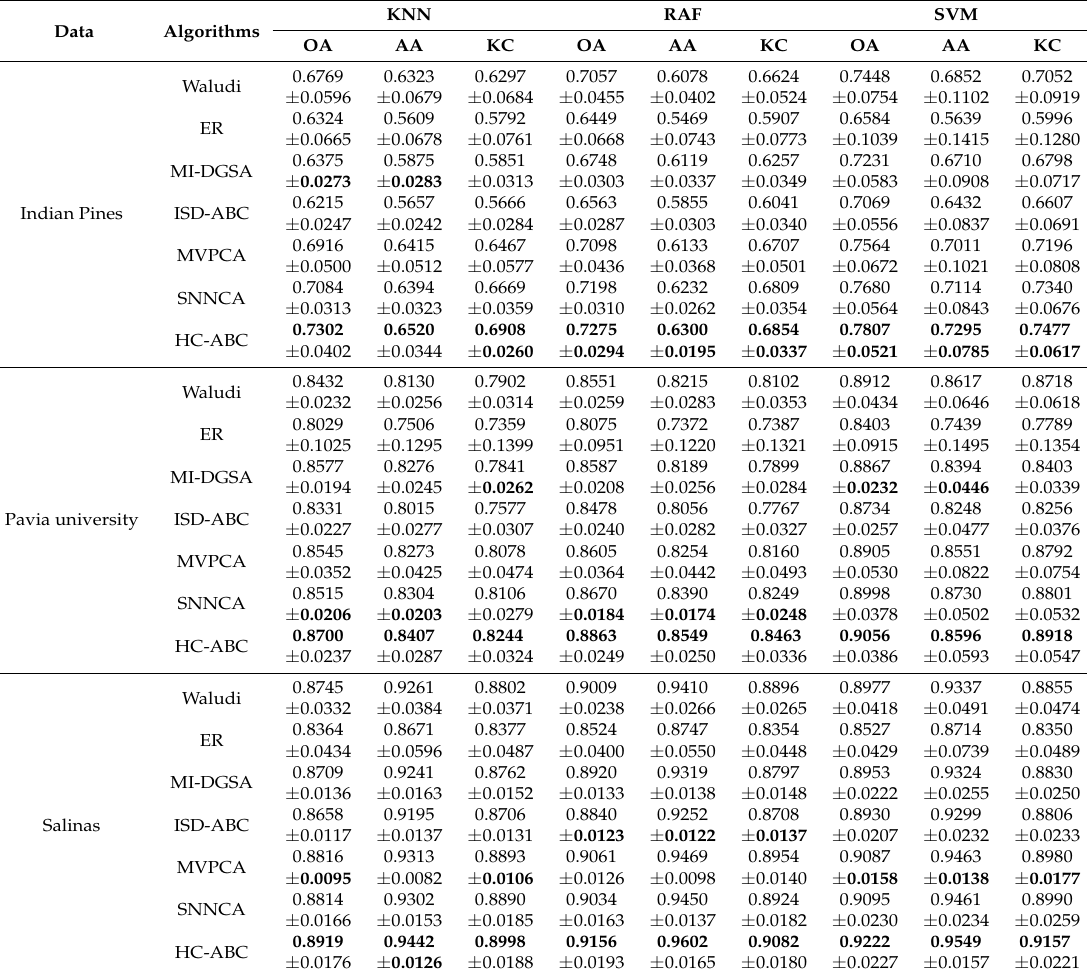
Table 3. The average performance values of the 7 algorithms on all the three data sets.